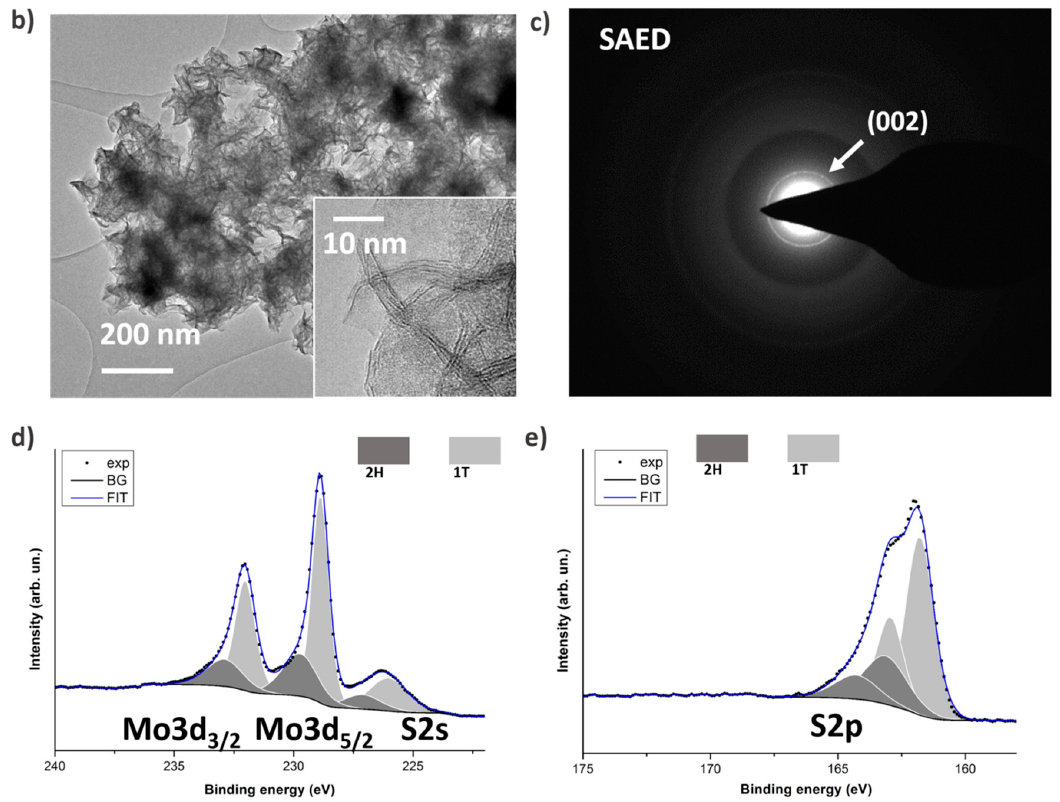
Figure 3. ( a ) Schematic representation of dip-coating of MoS 2 on carbon fiber (CF); ( b ) shows a low-magnification TEM image of the MoS 2 nanoflakes, while the inset provides a high-magnification image showing the layered structure of the nanoflakes, ( c ) provides a representative electron diffraction pattern. XPS high-resolution scans of Mo3d/S2s region ( d ) and S2p region ( e ) for MoS 2 nanoflakes are presented.